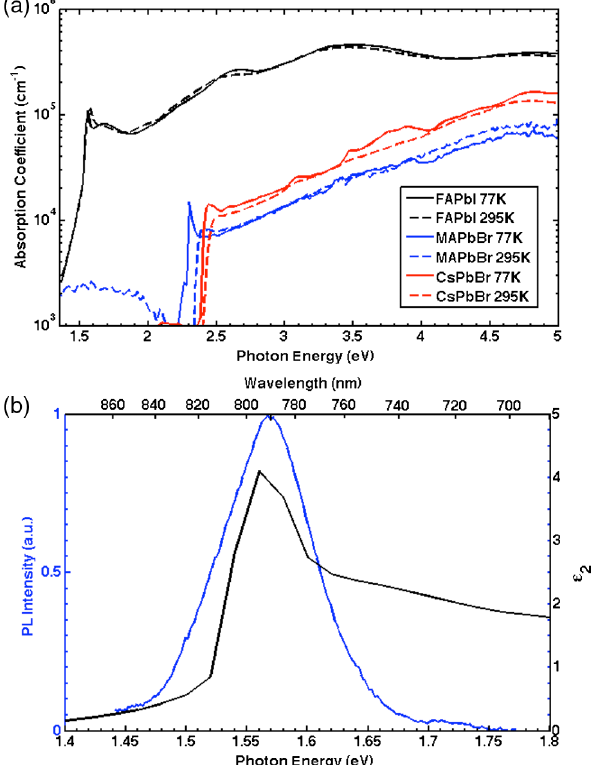
FIG. 6. (a) Comparison of absorption coefficients of FA 0 Cs 0 PbI 2 Br 0 , MAPbBr 3 , and CsPbBr 3 at different . 85 . 15 . 9 . 1 temperatures. (b) Comparison of photoluminescence and the dielectric function ε 2 for FA 0 Cs 0 PbI 2 Br 0 to further sup- . 85 . 15 . 9 . 1 port the presence of an exciton at about 1.55